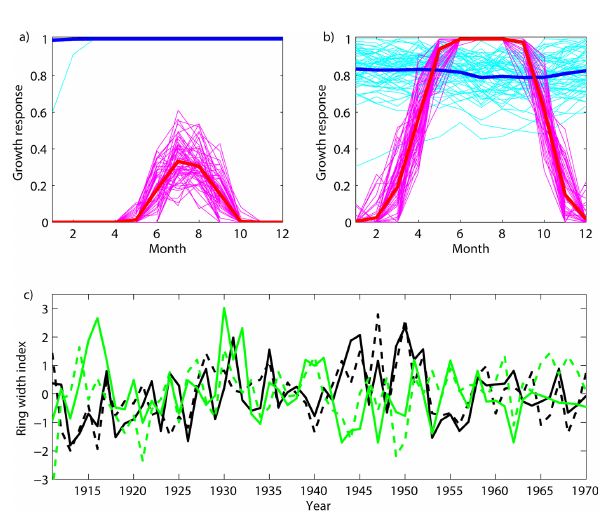
Fig. 4. Simulated monthly growth response curves for each year (1911–1970) for temperature ( g T , magenta lines) and moisture ( g M , cyan lines) for two sites in Switzerland: (a) Bergün Val Tuors, European larch, 2065m, and (b) Krauchthal, Scots pine, 550m. The long-term (1911–1970) mean value is overlaid in red for tempera- ture and in blue for moisture; (c) TRW ITRDB and TRW VSL (dashed lines) for Bergün Val Tuors (black lines), r = 0 . 69, p < 0 . 01 and Krauchthal (green lines), r = 0 . 44, p < 0 .